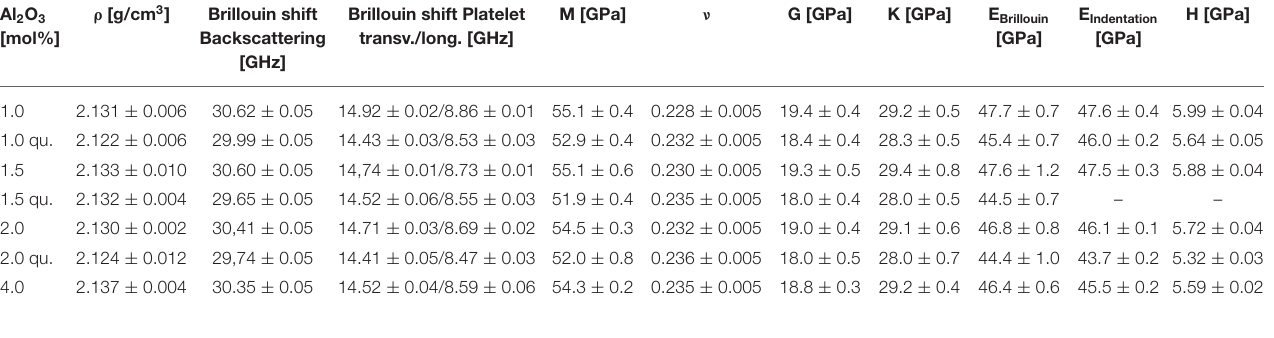
TABLE 3 | Density and mechanic properties of the investigated NBS2 glass series obtained by Brillouin spectroscopy and nanoindentation testing. ρ [g/cm 3 ] Brillouin shift Al 2 O 3 [mol%] Backscattering [GHz]